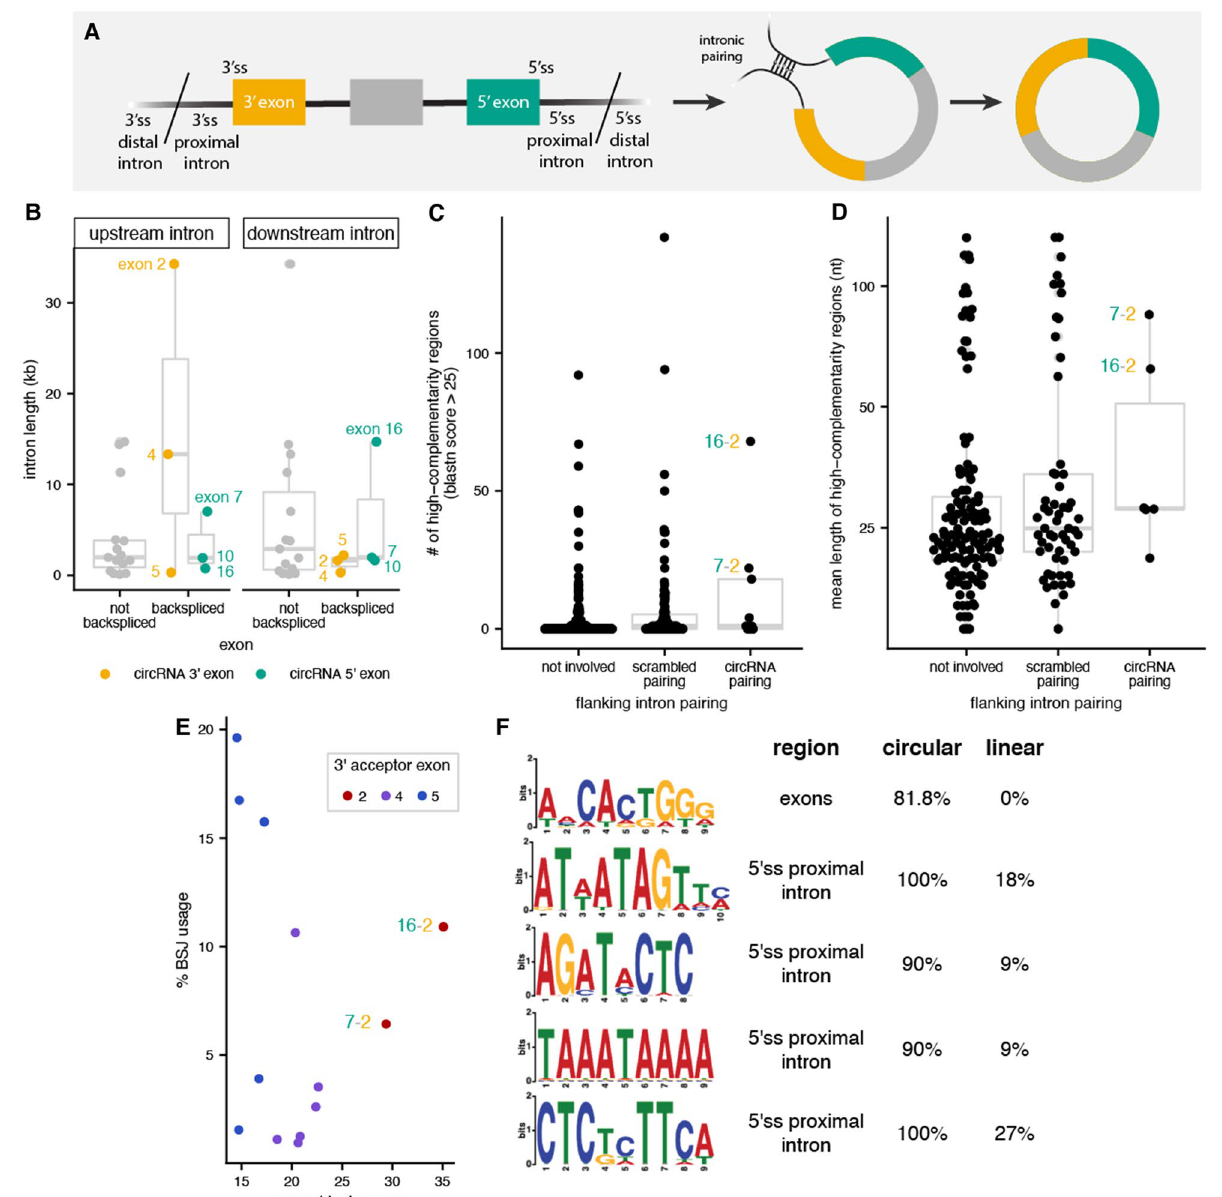
Figure 3. ANRIL back-splicing is associated with sequence features. ( A ) Schematic for BSJ involved 3’ and 5’ splice site (ss) proximal introns used as input for motif enrichment ( left ) and intron pairing ( right ). ( B ) Distribution of intron lengths ( y-axis ) for 3’ and 5’ back-spliced exons ( yellow and green , respectively) and exons not involved in back-splicing ( grey ). ( C ) Distribution of the number of high complementarity (blastn > 25) regions ( y-axis ) within pairs of flanking introns. ( D ) Distribution of length for high complementarity regions ( y-axis ) within pairs of flanking introns. ( E ) Correlation between mean complementarity scores from blastn for high complementarity regions ( x-axis ) and %BSJ isoform usage ( y-axis ) for frequently used 3’ exons. ( F ) Sequence motifs enriched in ANRIL BSJ-involved exons or flanking introns, with percent occurrence in circular or non-circular (linear) regions indicated on the